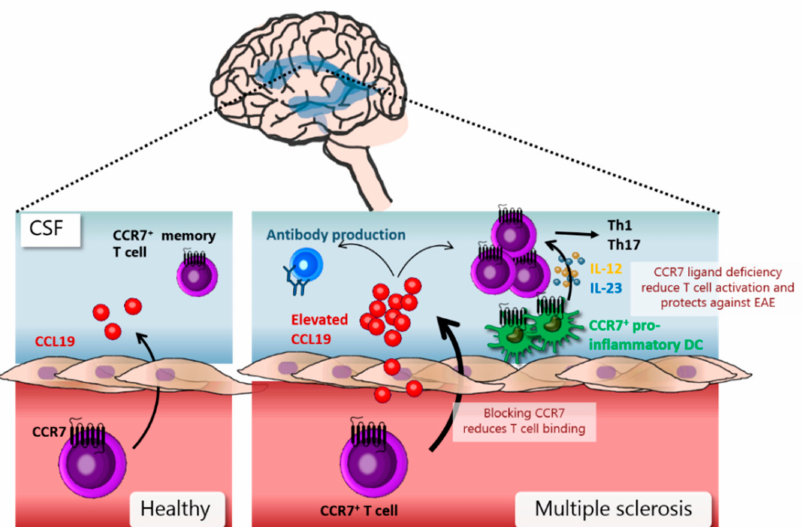
Figure 4. CCR7 and dendritic cells (DCs) in multiple sclerosis (MS): In healthy individuals, CCR7 and CCL19 are involved in the normal trafficking of memory T cells into the brain. In MS, elevated levels of CCL19 can be found in the CSF (cerebrospinal fluid). MS is associated with an increase in T cell infiltrates and an increase in pro-inflammatory CCR7 + DCs in the CSF. Blocking CCR7 reduces the binding of T cells to the endothelium and recruitment into the CSF. CCR7 signaling in DCs leads to the release of IL-12 and IL-23, which, in turn, induces T-cell activation. Deficiency of CCR7 ligands reduce T-cell activation and protects against EAE in the EAE mouse